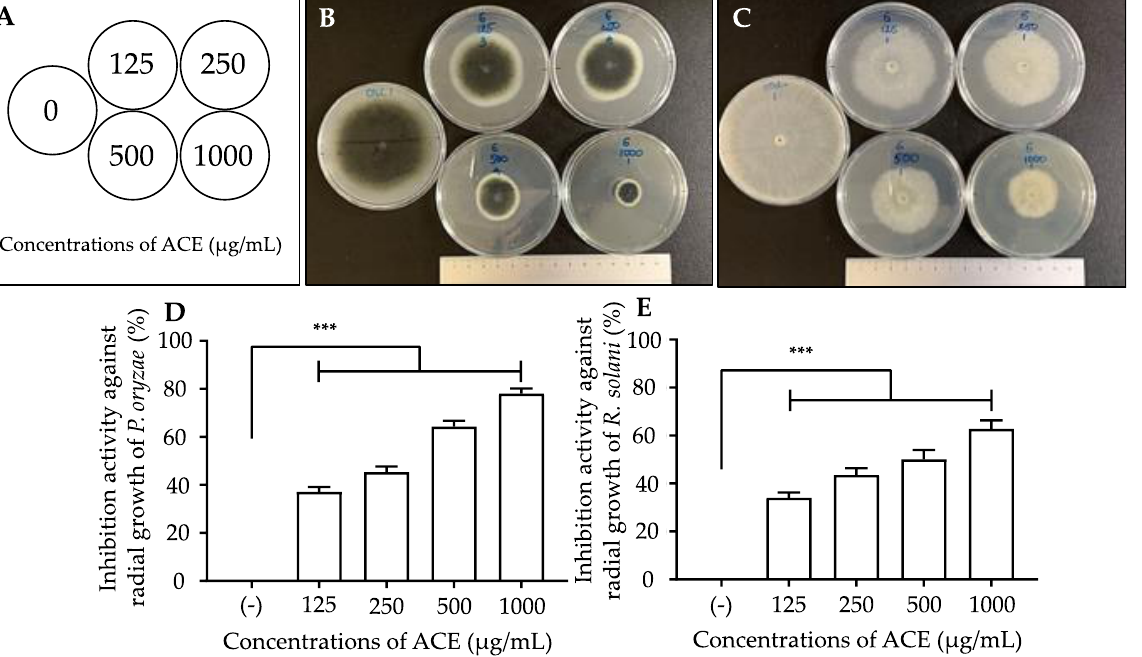
Figure 1. Inhibitory activities of ACE against mycelial growth of P. oryzae ( B , D ) and R. solani ( C , E ). P. oryzae and R. solani were inoculated on PDA plates containing different concentrations of ACE shown in ( A ). After incubation at 26 °C for 14 days ( P. oryzae ) or 2 days ( R. solani ), the diameters of mycelial growth area of fungi were measured in mm, and PI (%) was calculated ( D , E ). n = 5; data are presented as mean ± SD; ***, p < 0.001.